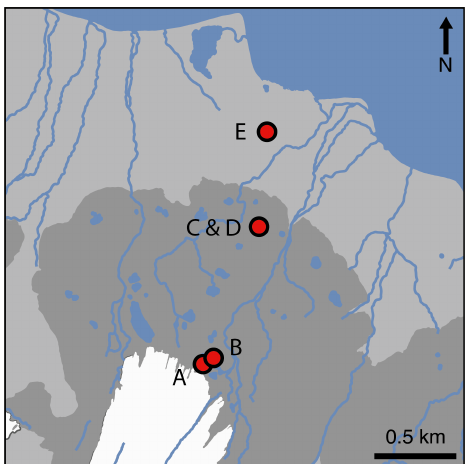
Figure 1. Locations of snout (A), pond mat (B), disturbed mat (C), established mat (D), and tundra (E) sites on the forefield of Midtre Lovénbreen glacier (white). The moraine field is denoted in dark grey, the maximum extent of which marks the furthest extent of the glacier during the Little Ice Age. Data used to create the base map are from Norwegian Polar Institute